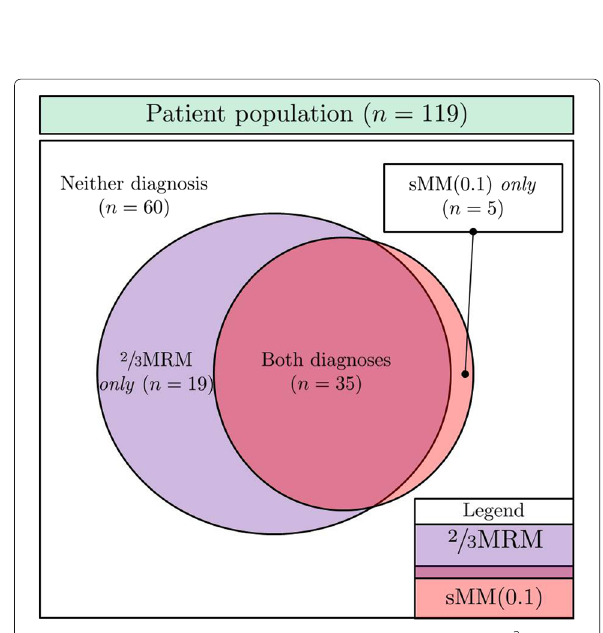
Fig. 5 Venn diagram for the patient population classified by 2 and sMM(0.1). We observe considerable concordance between the two diagnoses, but also noteworthy